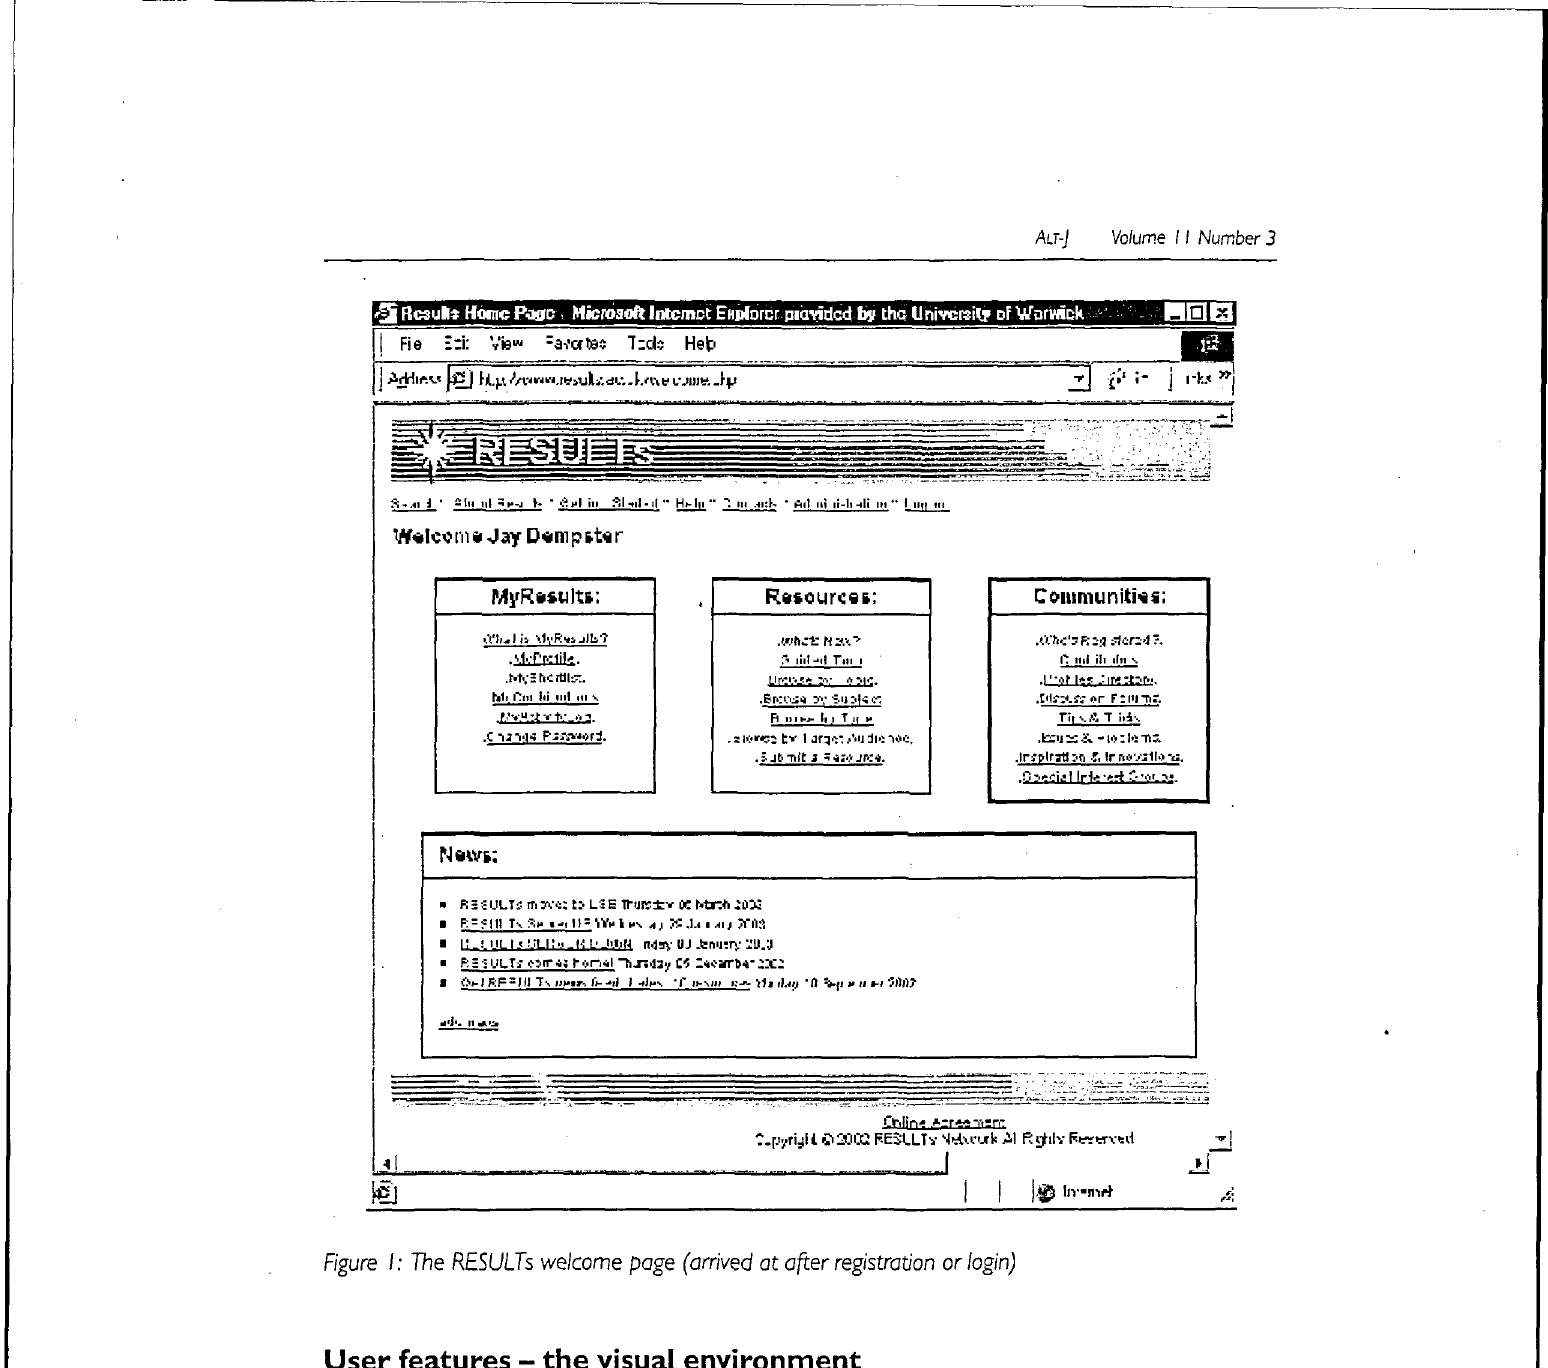
User features - the visual